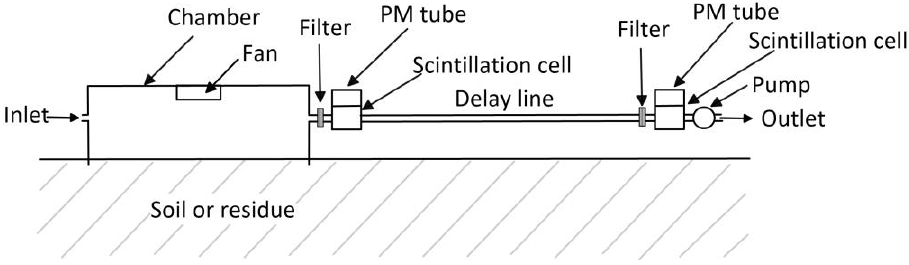
Figure 8. Schematic representation of double cell flow through system (taken from Figure 8 . Schematic representation of double cell flow through system (taken from [112]).